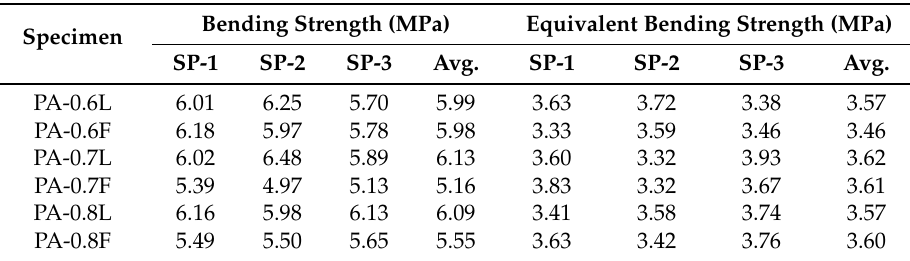
Table 6. Bending and equivalent bending strength.